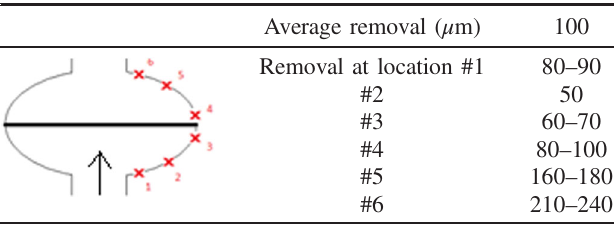
TABLE I. Measured material removal at 6 locations in the cavity at 6 V and 8 L = min acid flow rate. Fluid circulates from